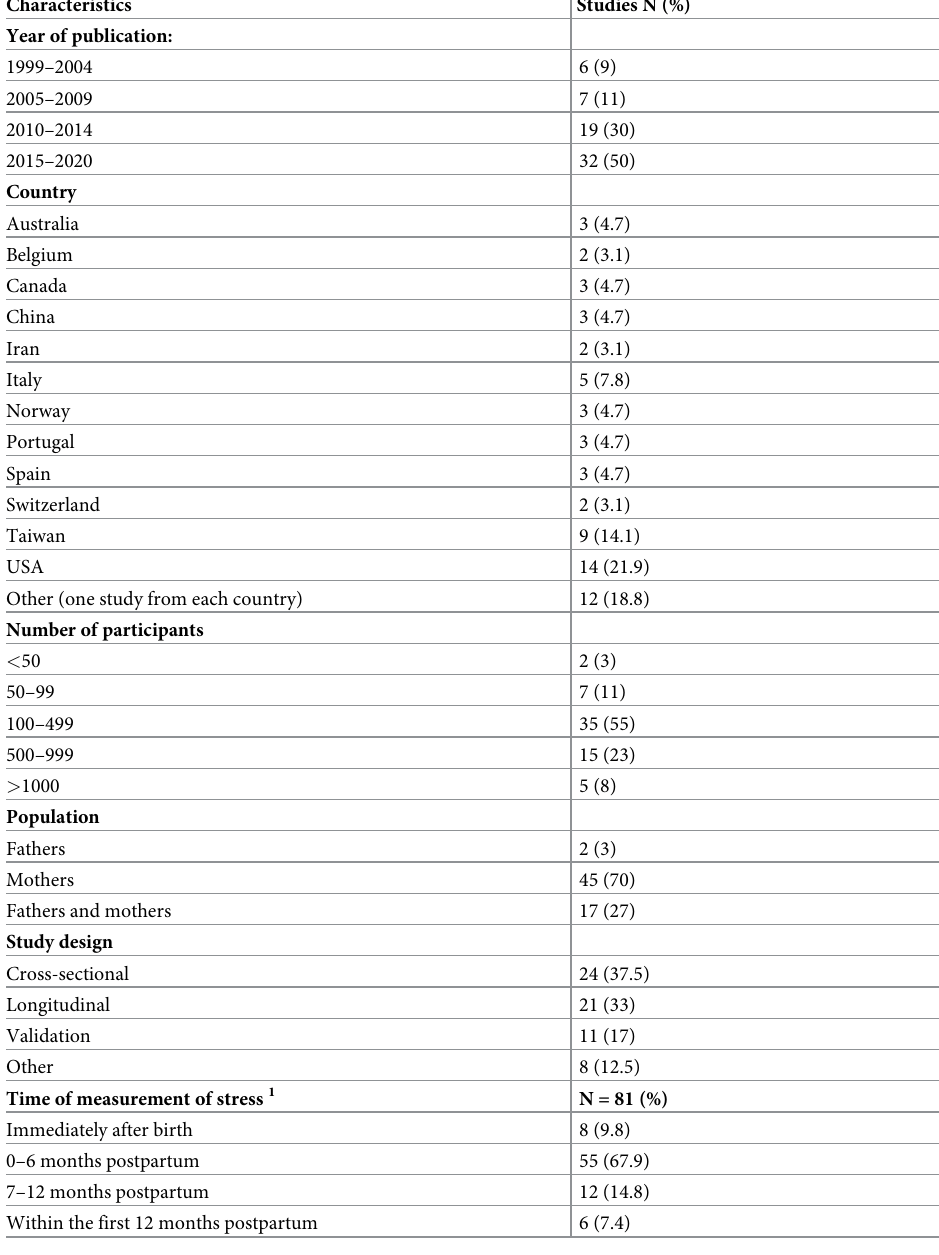
Table 1. Summary characteristics of the included studies (N = 64).